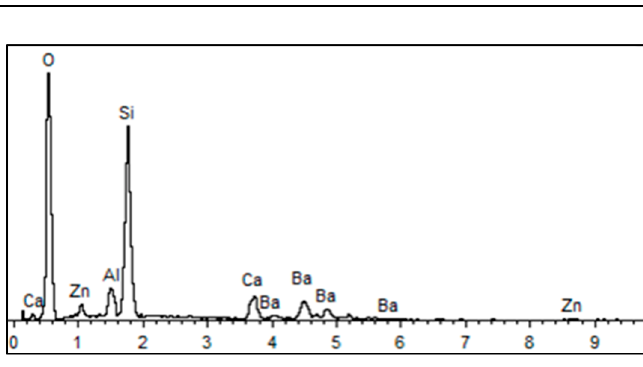
Figure 4. Energy-dispersive X-ray (EDX) spectrum of D-ZK3L.